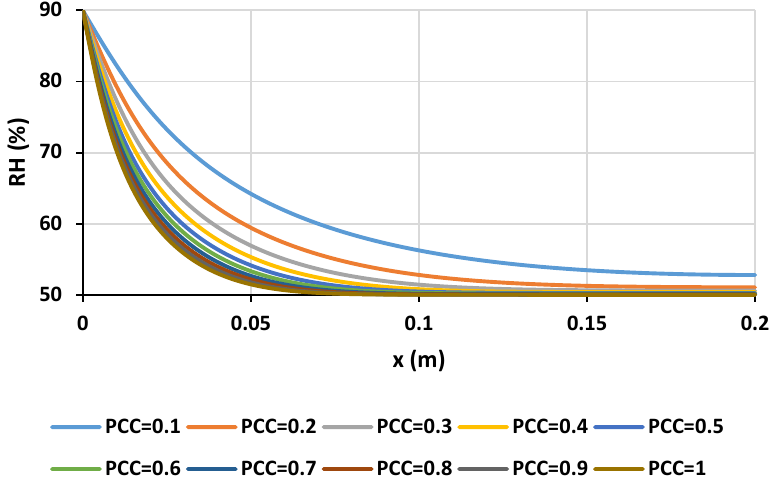
Figure 19. Influence of PCC on the RH profile inside RES.